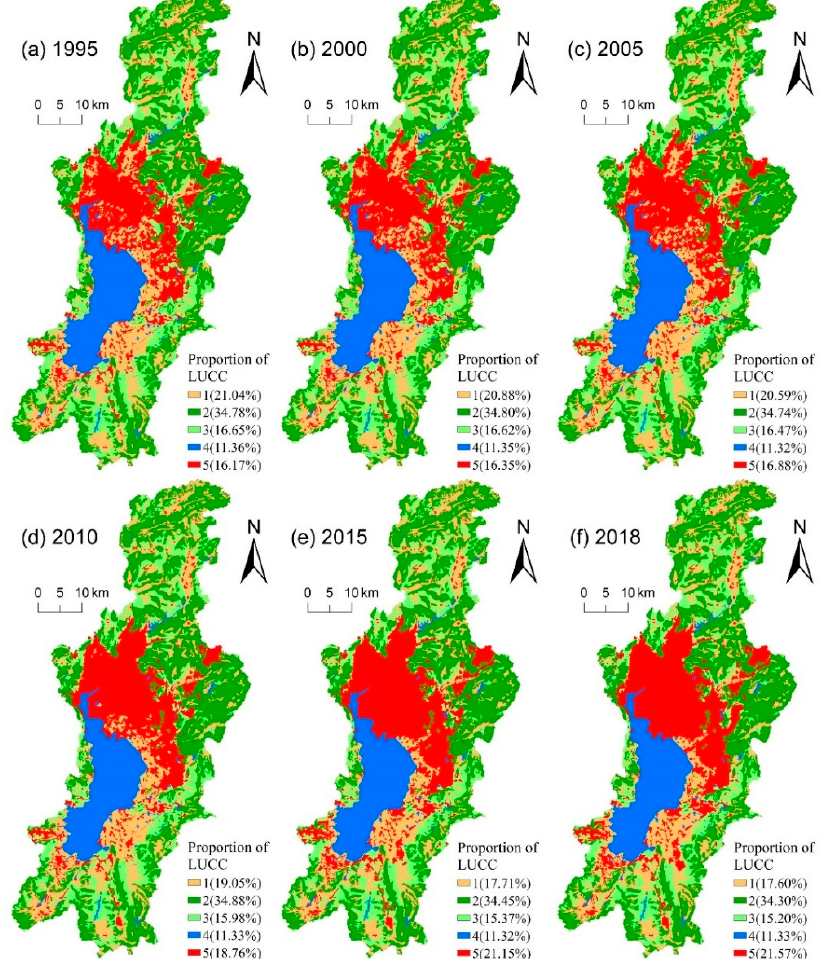
Figure 3. LUCC structure and distribution in the Dianchi Lake basin of China from: ( a ) 1995, ( b ) 2000, ( c ) 2005, ( d ) 2010, ( e ) 2015, ( f ) 2018. Note: 1: Cultivated land, 2: Forestland, 3: Grassland, 4: Water area, 5: Construction land.